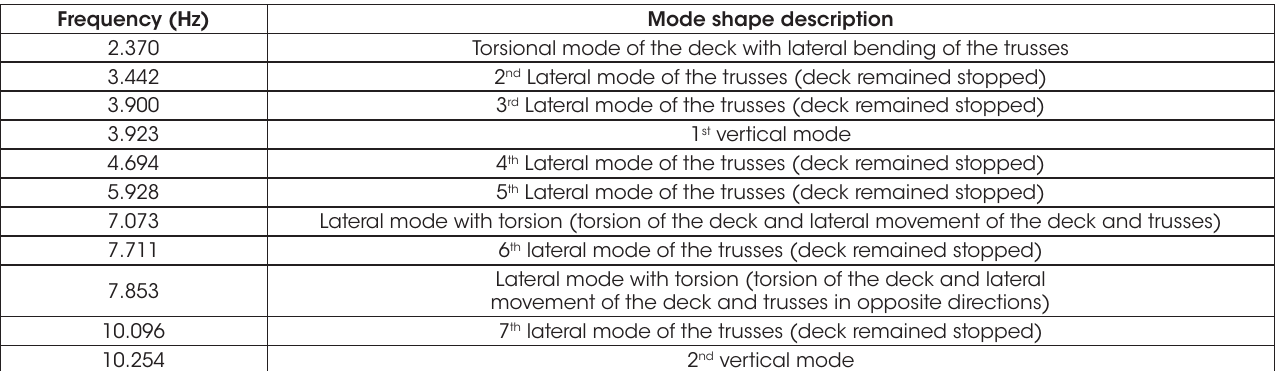
Frequencies and mode shapes description obtained for the model in which the deck was modeled as shell elements. (Brasiliano et al.